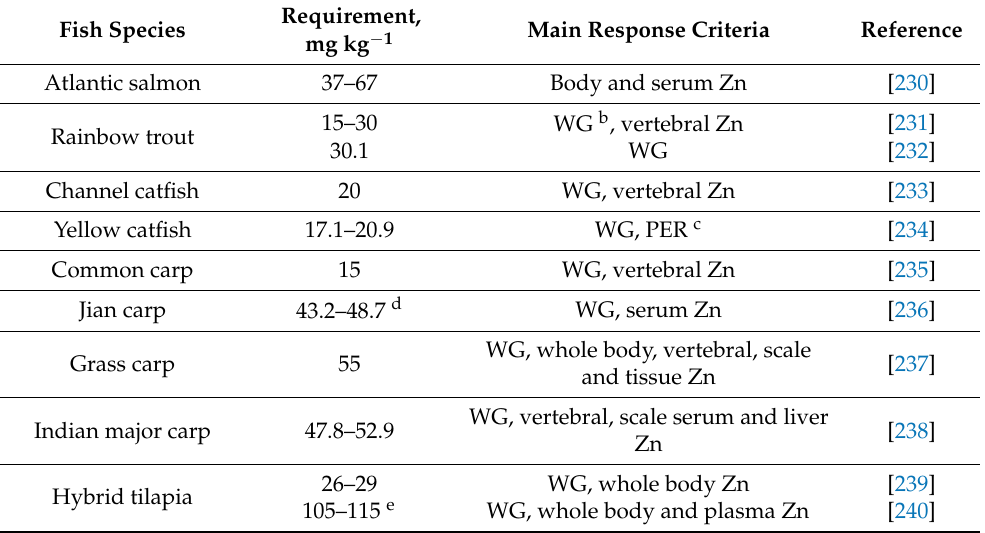
Table 4. Zinc requirements of certain fish a